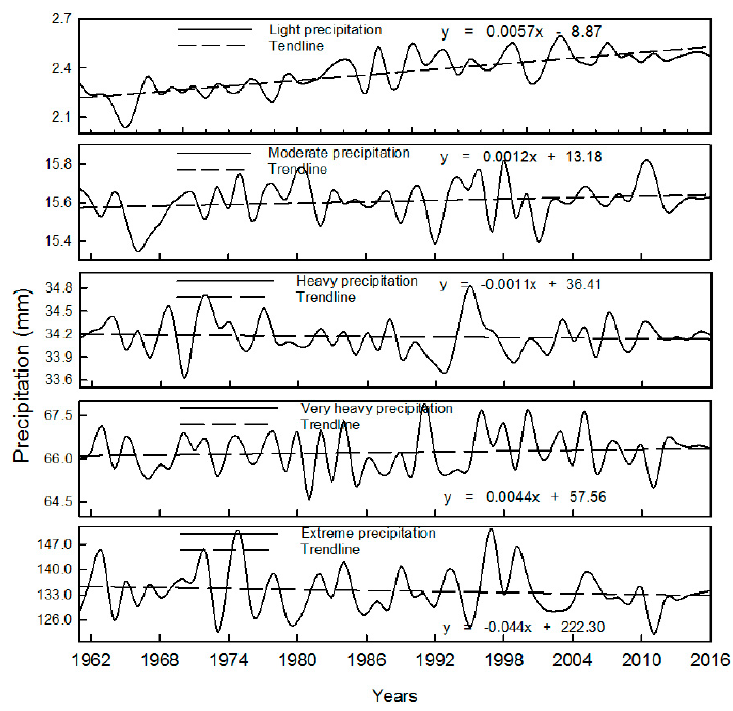
Figure 7. Interannual variation of precipitation intensity of each grade.